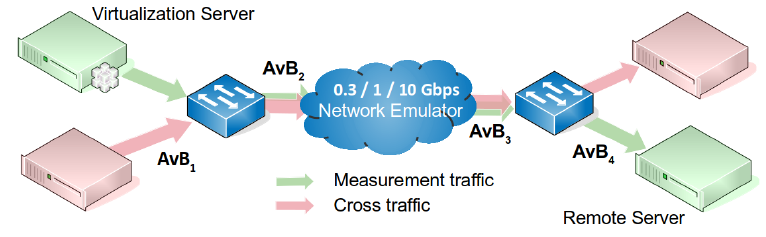
Figure 3. AvB Network